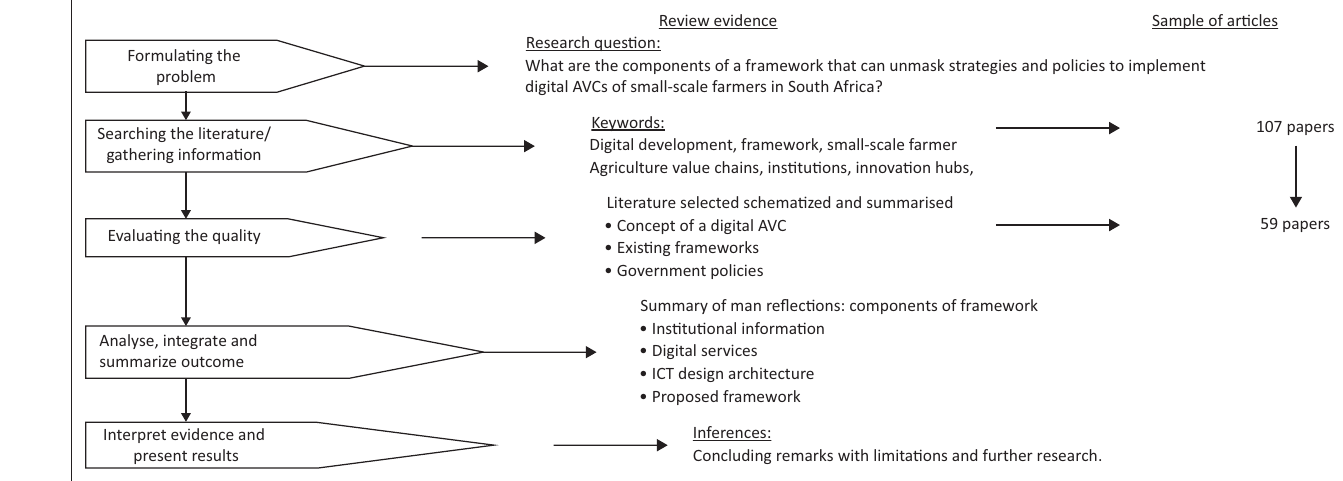
FIGURE 1: Adoption of the systematic literature